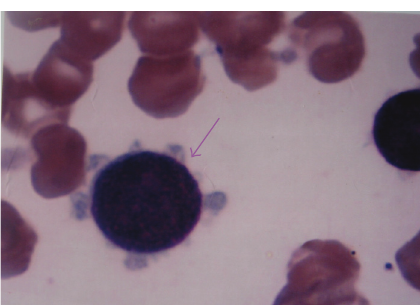
Figure 2: Megakaryoblast with platelet budding (1000X).